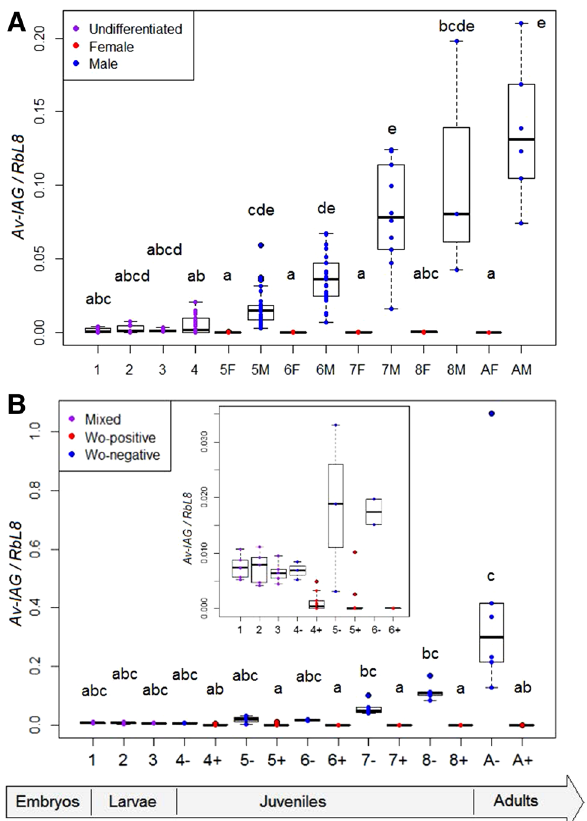
Figure 2. RT-qPCR expression profiles of the Av-IAG mRNA during development in uninfected ( A ) and Wolbachia -infected lineages ( B ). The expression level of the Av-IAG gene was normalised to the one of the RbL8 housekeeping gene. Pools of undifferentiated larvae were sampled after birth (stage 1), one and two weeks after birth (stages 2 and 3, respectively). Animals were sampled individually for stage 4 (undifferentiated juveniles), stages 5–8 and into adulthood: ( A ) genetic males and females (AM for adult males, AF for adult females) or ( B ) Wolbachia -infected or uninfected individuals (A+, A−); insert: focus on stages